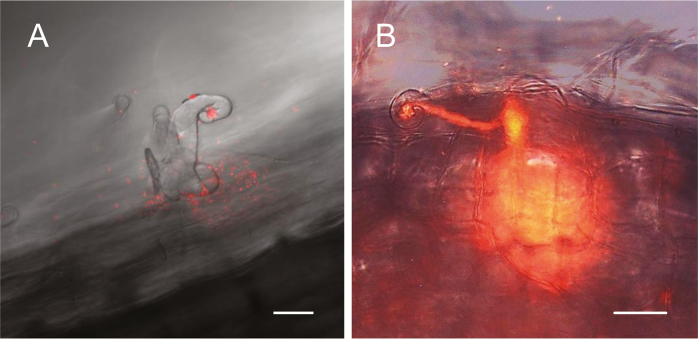
Typical (A) incipient IT and (B) long IT in roots of WT plants after 14 d of inoculation. Images were taken with a confocal microscope. Scale bars=25 μm.